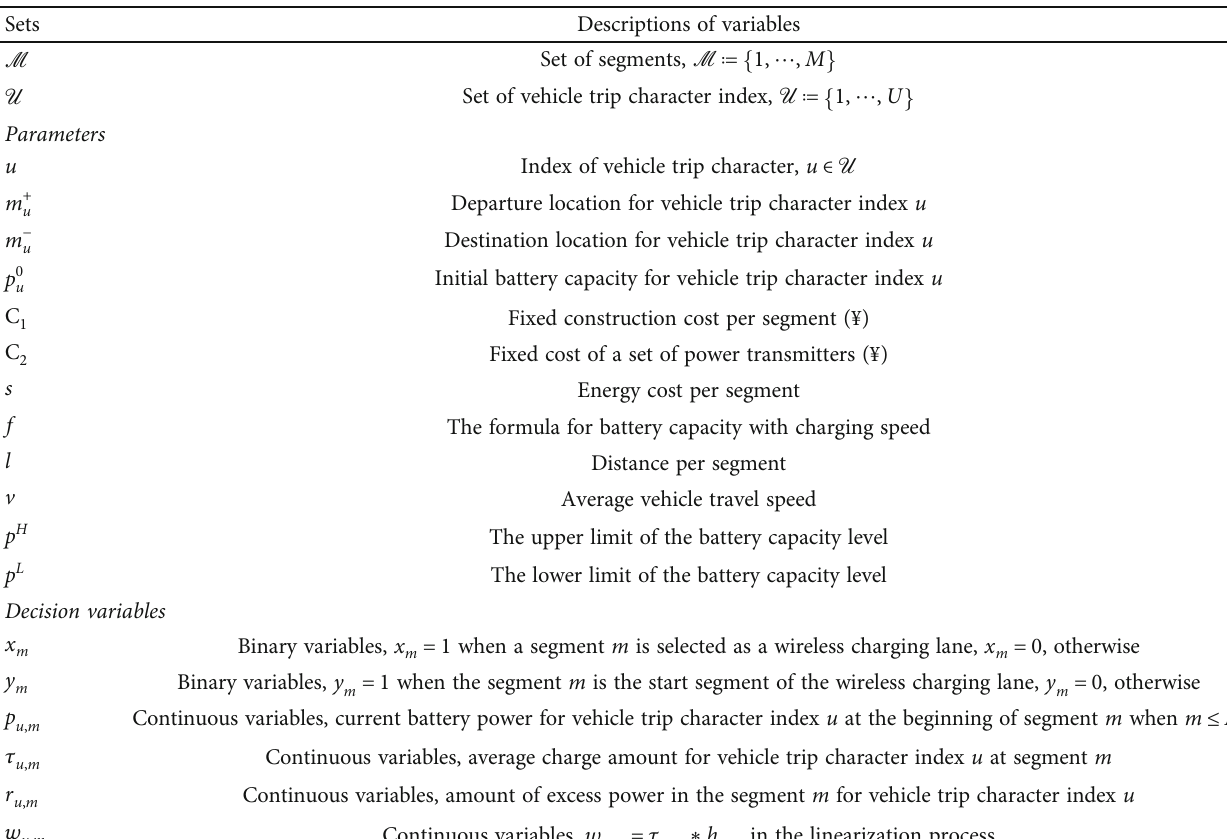
Table 2: Notation.